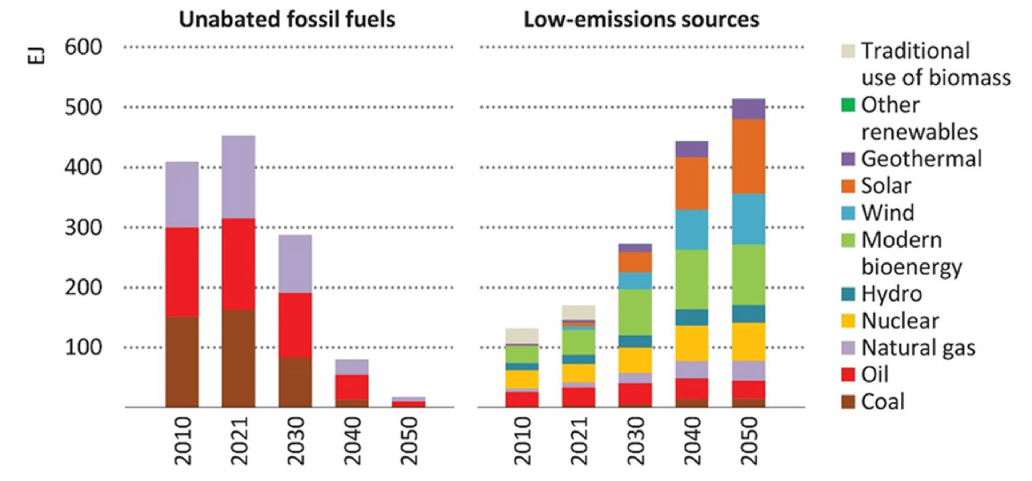
Figure 4. The NZE Scenario ’ s 2010 – 2050 fossil fuel and low-emission energy supply [58] . As indicated in Figure 5, desalination methods fall into two categories: desalination thermal processes or with phase change and desalination with membrane processes or single-phase methods. Multistage flash (MSF), multiple-effect distillation (MED), vapor compression (VC), and freezing are the phase-change desalination processes. Single- phase desalination methods include electrodialysis (ED), reverse osmosis (RO), mem- brane distillation (MD) , and capacitive deionization (CDI). Multistage flash, reverse os- mosis, electrodialysis, multiple-effect distillation, and hybrid technologies are economi- cally viable and widely utilized desalination methods, accounting for 63%, 22%, 8%, 3%, and 3% of the market share, respectively [59] . Figure 5. Different methods of water desalination. 3.1. Single-Phase Desalination Hydraulic pressure and electricity are the main forms of energy required for mem- brane-based desalination. In this category, membrane distillation (MD), electrodialysis, and reverse osmosis are the most often employed technologies. In the RO procedures, high-pressure pumps must be driven by electricity or shaft power. Two streams are pro- duced during the MD process: one cool, freshwater stream and one hot, salty stream. A temperature differential between these two streams causes the transfer of water vapor.